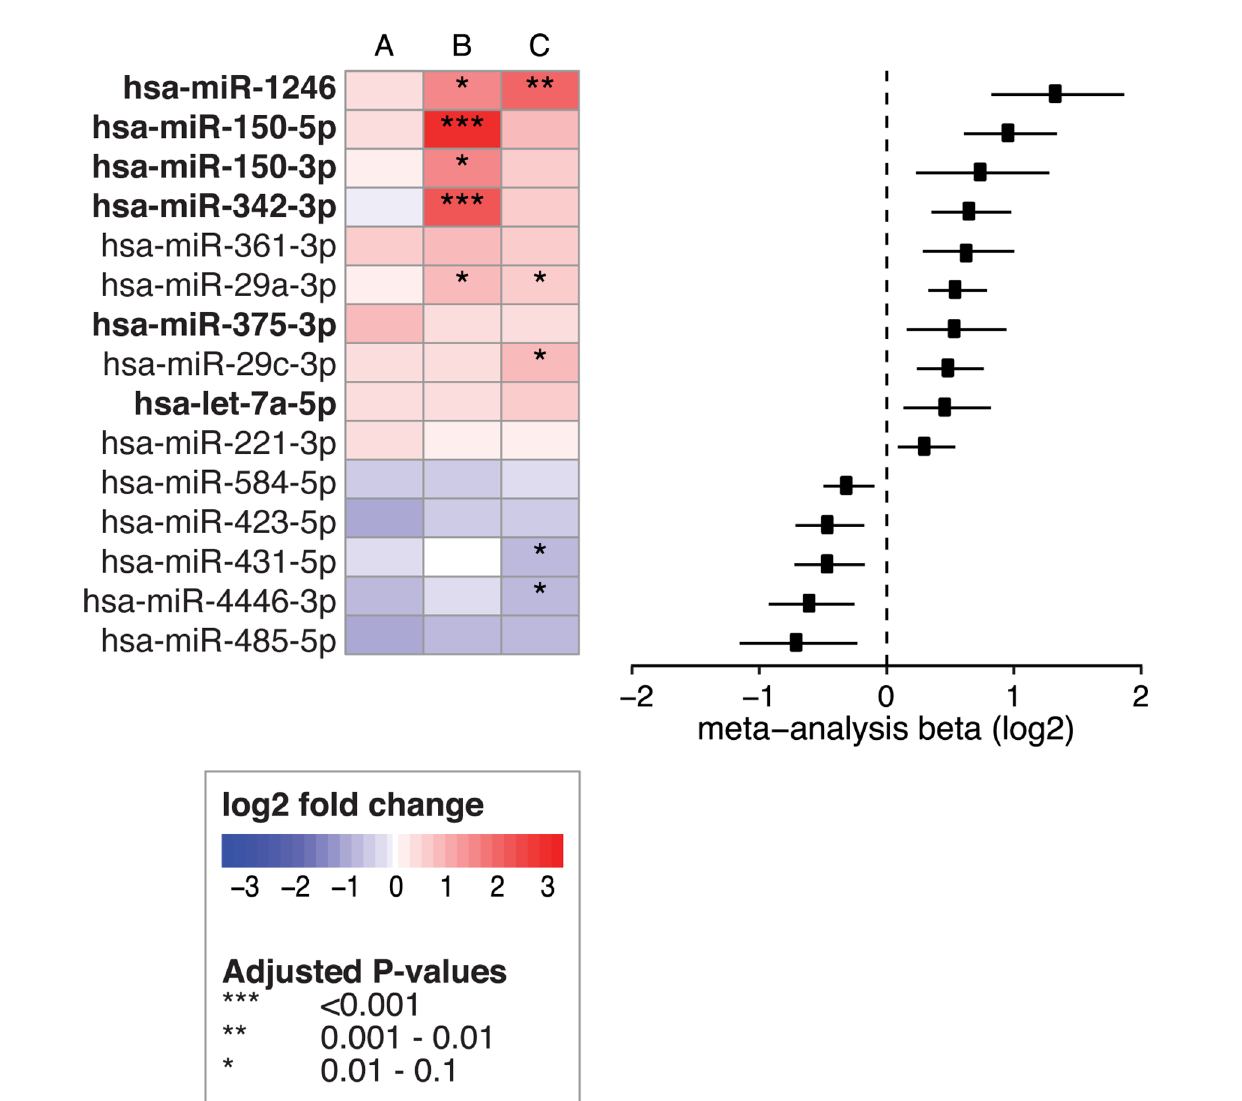
FIGURE 6 | Fifteen circulating miRNAs change after start of the GFD. Left panel shows the 15 circulating miRNAs that were signi fi cant in the meta-analysis when combining the following comparisons: (A) PreventCD: GFD vs CeD at diagnosis (taken at seroconversion or at time of biopsy) (B) Milano-Bicocca: GFD vs CeD at diagnosis and (C) GFD volunteers: GFD vs gluten containing diet. Right panel shows forest plot for the meta-analysis (beta and 95% con fi dence interval). Bold text indicates miRNAs that are also among the 53 CeD biomarker candidates and show a normalizing trend upon